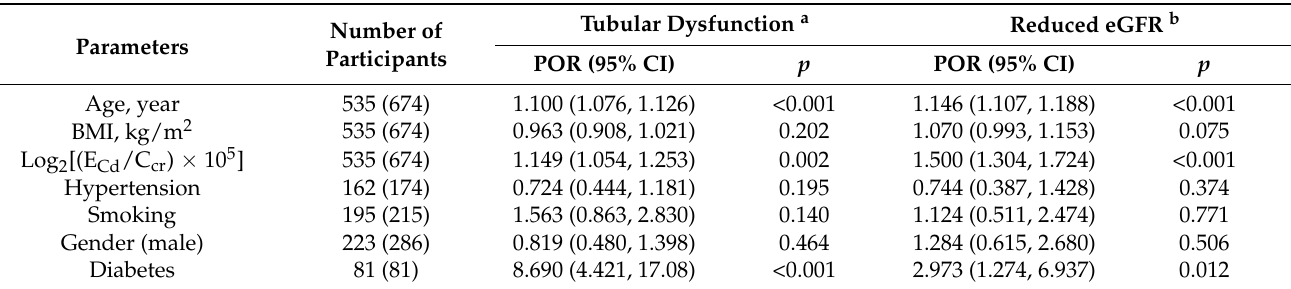
Table 2. Risk factors for tubular dysfunction and reduced